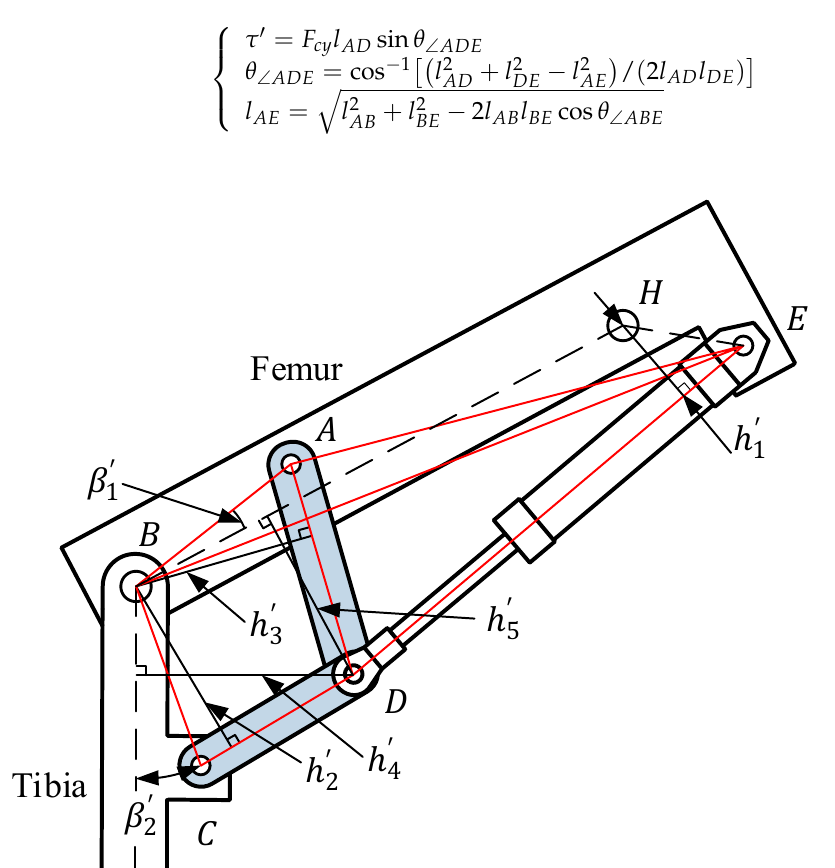
Figure 3. The FMAG of the cylinder at the knee joint.